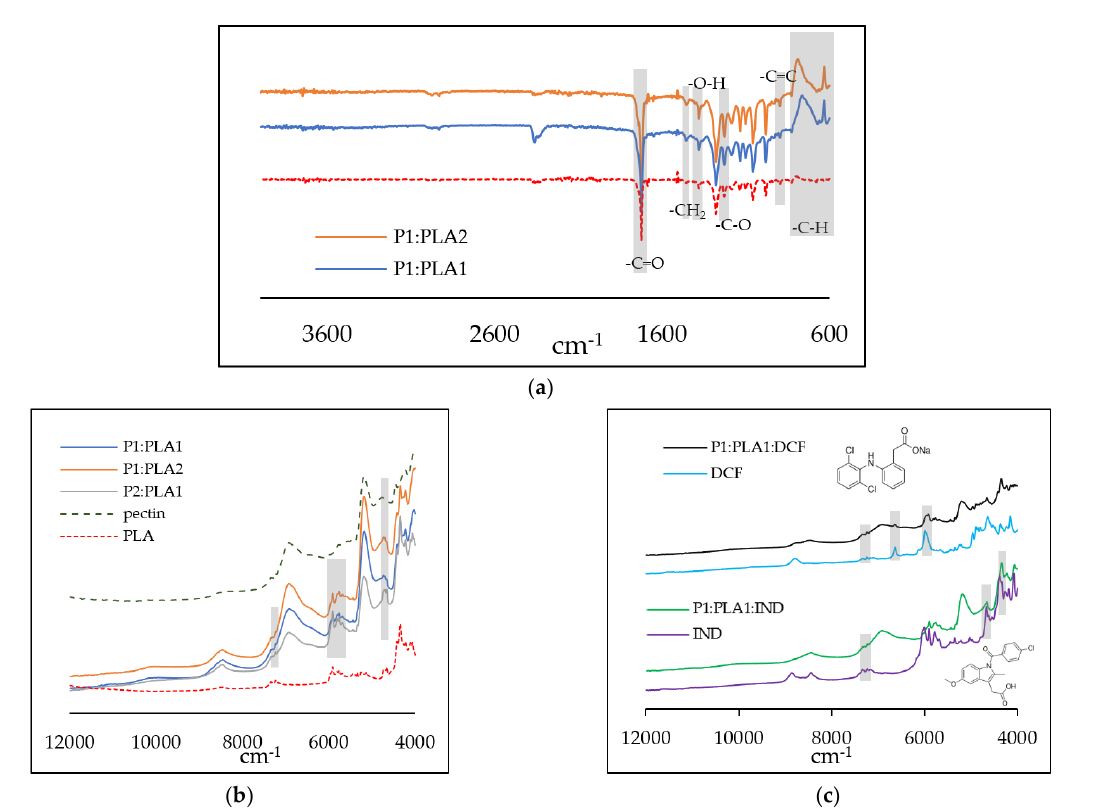
Figure 1. ( a ) FT − IR spectra of P1:PLA1, P1:PLA2, and PLA samples. ( b ) Comparison of FT − NIR spectra of the prepared hybrid samples and references, and ( c ) Comparison of the FT − NIR spectra of hybrid samples loaded with model drugs IND and DCF with the native spectra of pure model drugs.